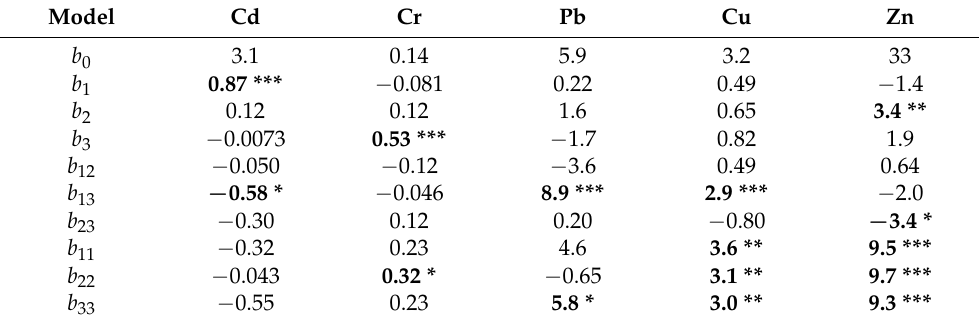
Table 2. Regression coefficients estimated for the models of DoE. b 0 is the intercept, the other subscripts of the regression coefficients ( b i ) indicate the i -th factors (metals): (1) Cd; (2) Pb; (3) Cr. Bold values indicate the statistically significant factors ( p -values lower than α = 0.05), stars indicate the significance level (* indicates p < 0.05; ** p < 0.01; *** p < 0.001).